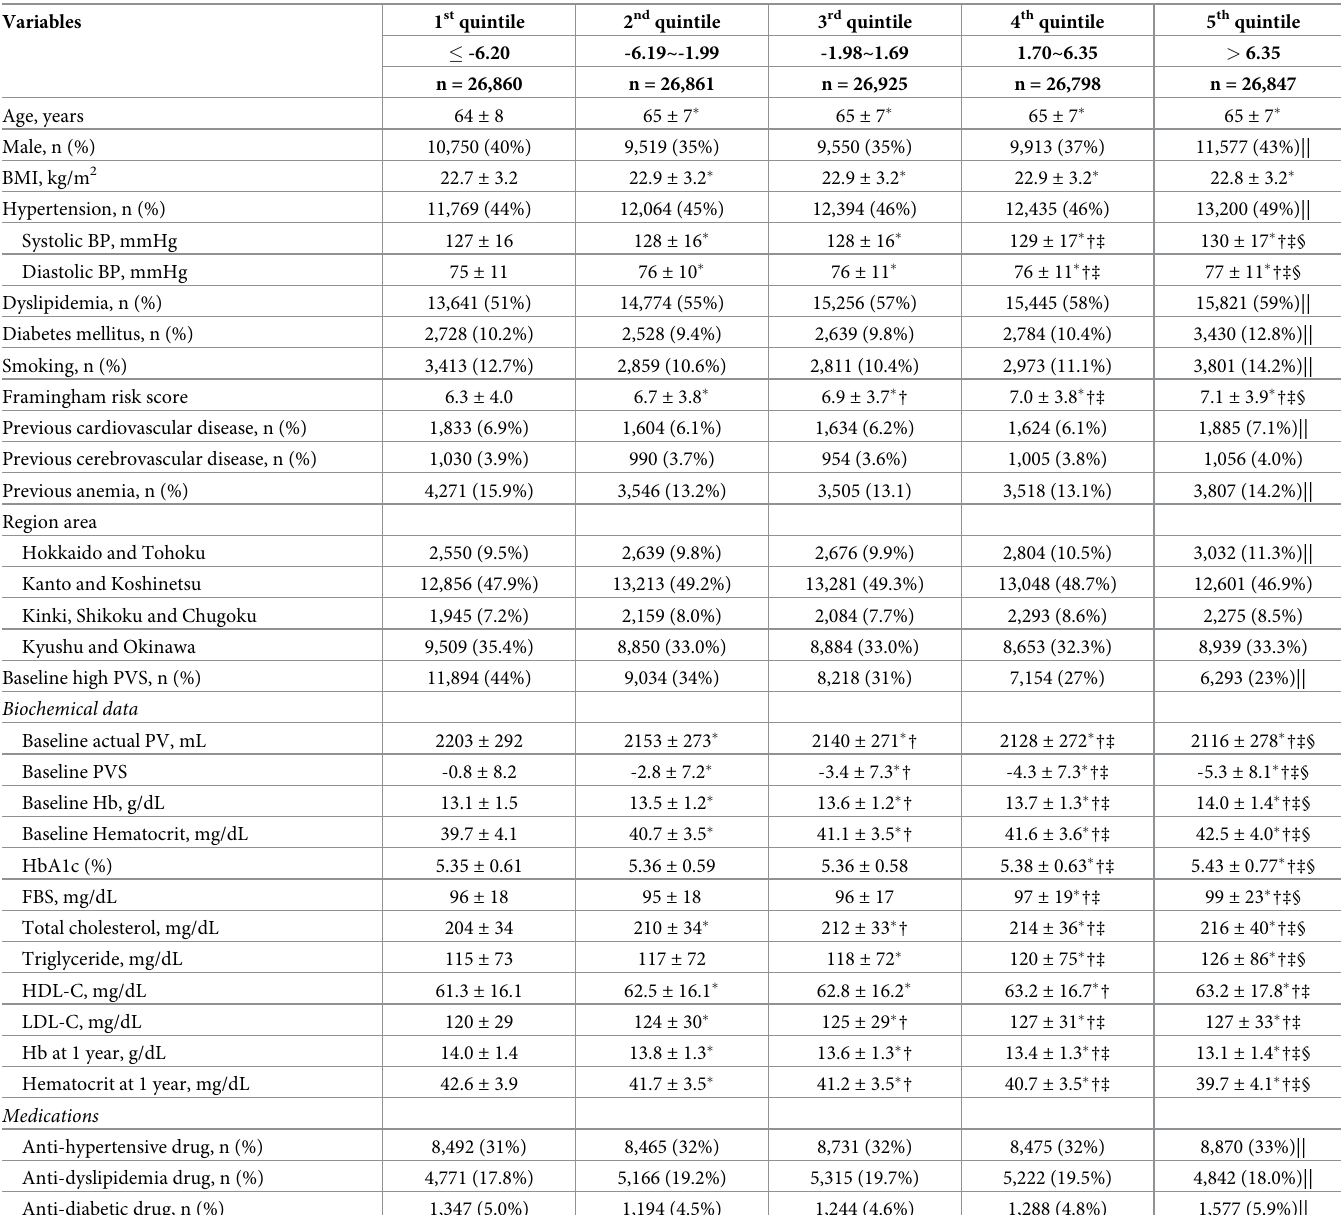
Table 2. Comparison of clinical characteristics among quintiles based on 1-year change in plasma